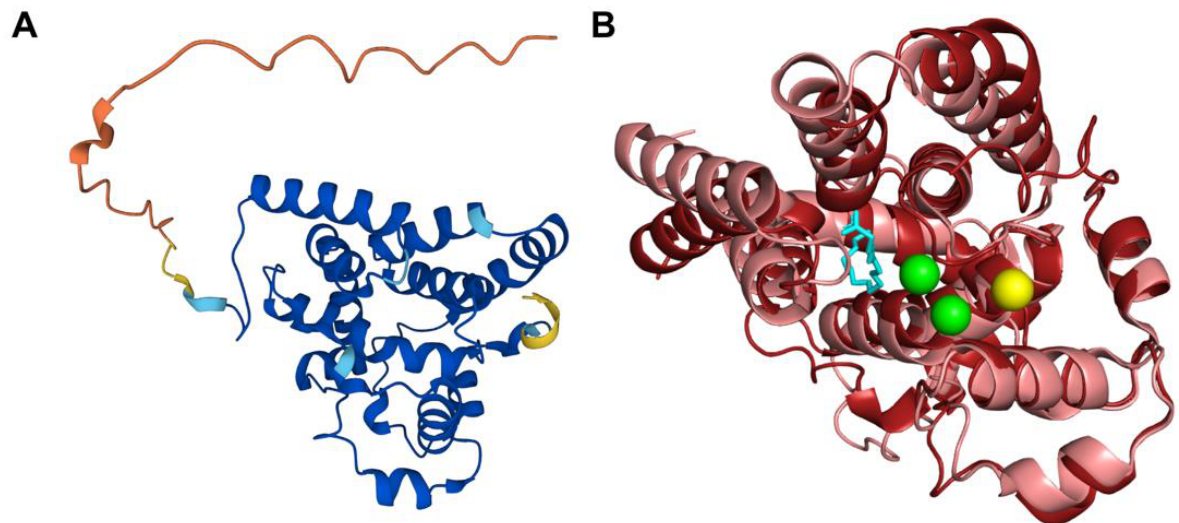
Figure 10. Comparison of the COQ4 AlphaFold model and the structure of Alr8543. ( A ) AlphaFold model of single chain of COQ4. Model color corresponds to model confidence as described in Figure 4. Figure was generated by the AlphaFold Protein Structure Database; adapted with permission from [39,54]. ( B ) Structural alignment of the human COQ4 AlphaFold model (shown in dark red) and Chain B of the crystal structure of Alr8543 protein (shown in salmon, PDB: 6E12) in complex with oleic acid (shown in cyan), Mg 2+ (shown in green), and Cl − (shown in yellow). Residues 1 – 44 of the AlphaFold model were omitted due to disordered structure.